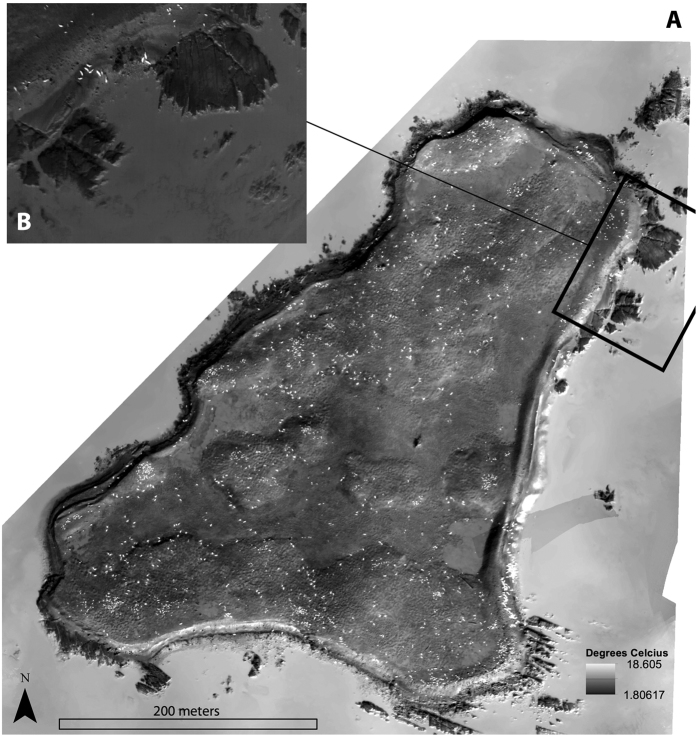
 A thermal infrared spatial index map (A) and a representative individual thermal infrared image (B) of the grey seal colony at Hay Island, NS Canada. This footprint of the individual image is projected onto the spatial index, providing a detailed view of adult and YOY grey seals and the habitats surveyed (rock, beach and frozen ground). This map was created with ArcMap GIS software (version 10.4.1, Esri Inc.).